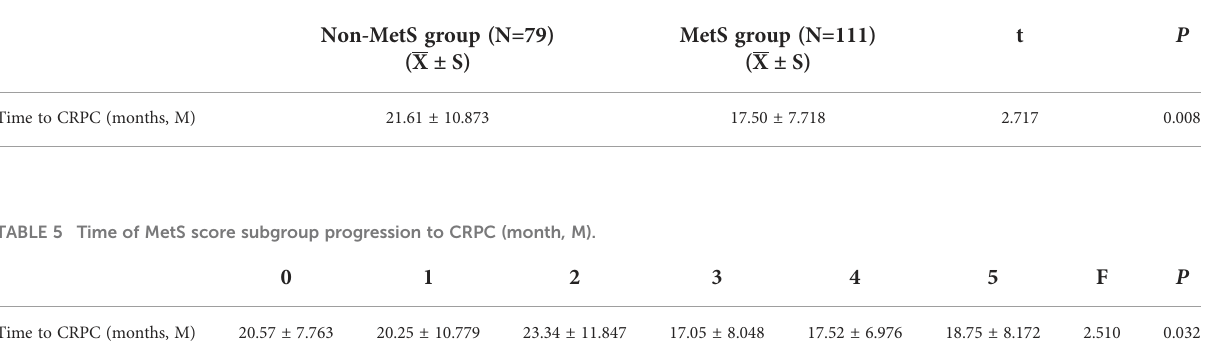
TABLE 4 Time of progression to CRPC between the Non-MetS group and MetS group (month, M).